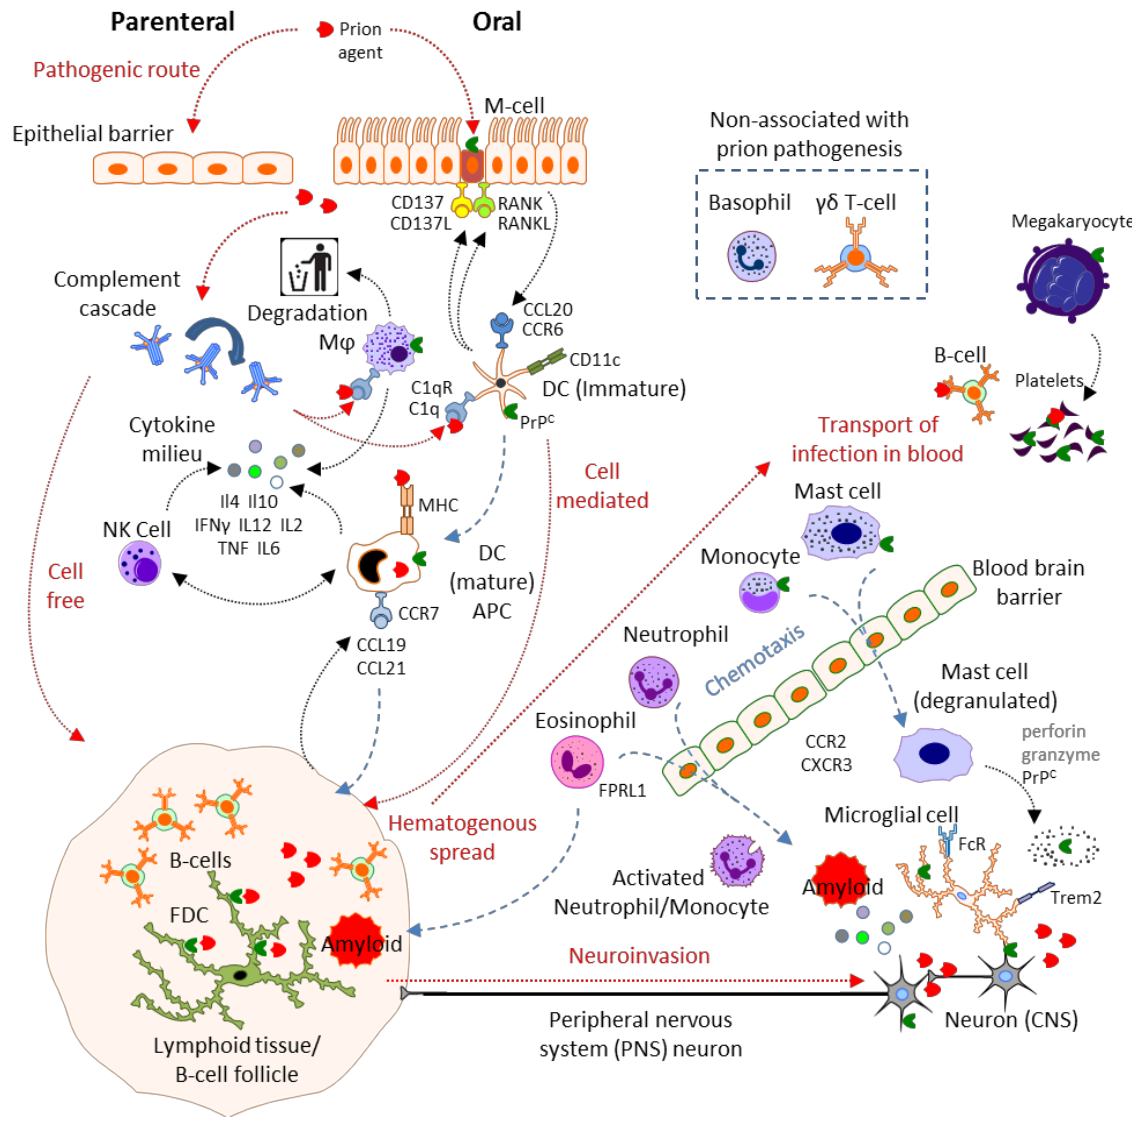
Figure 1. Prion disease and the innate immune system. Adapted with permission from motifolio.com, Biomedical PowerPoint Toolkit